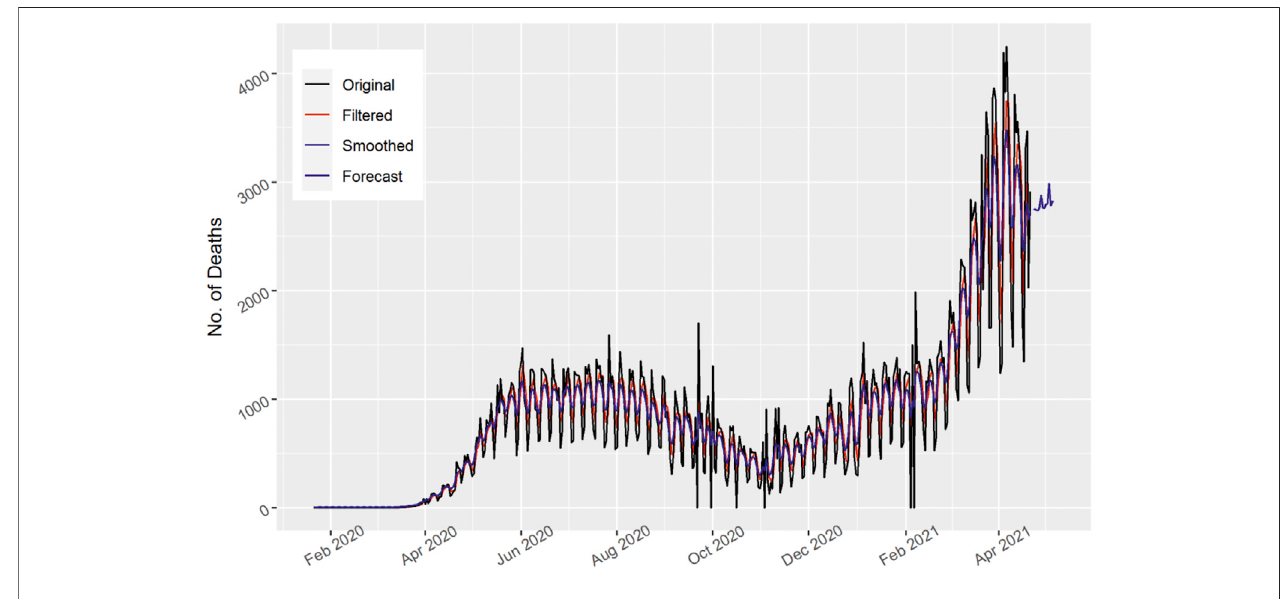
FIGURE 7 | Number of daily death cases in Brazil.